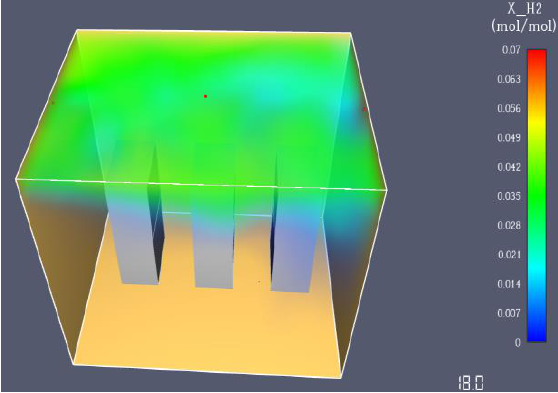
Figure 11. Leakage diameter 16 mm at the inlet of the bottom right stack (60 ACH).